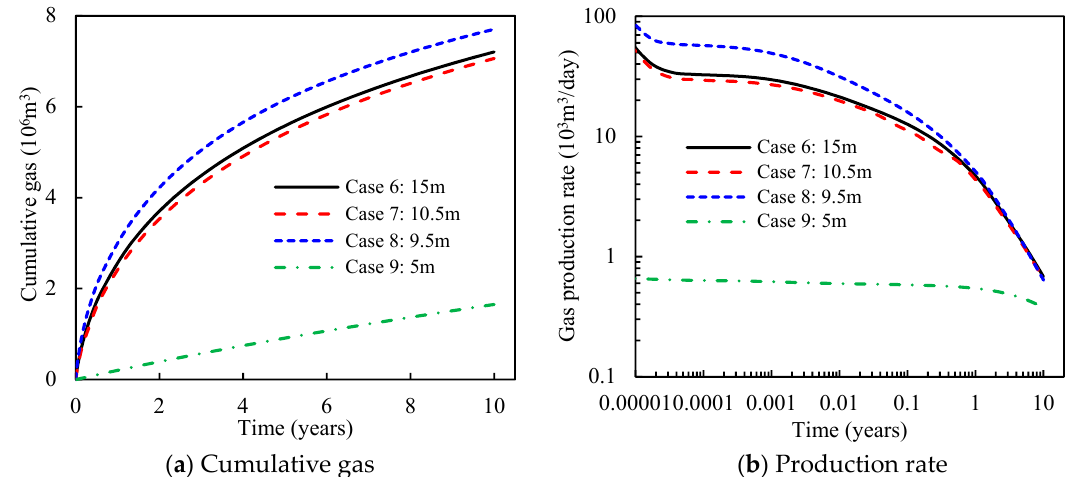
lg( k HF · d HF /md-m).